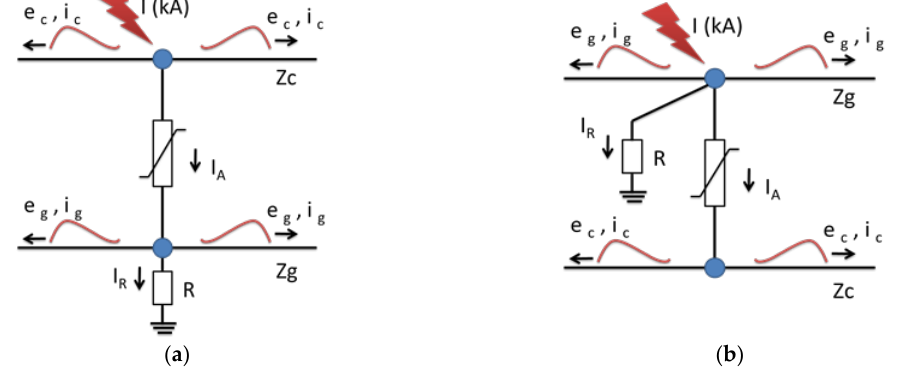
Figure 13. Result of a lightning strike to the phase conductor and overhead ground wire when the arrester is installed; ( a ) Strike to the phase conductor; ( b ) Strike to the overhead ground wire. The crest voltage at the phase conductor is given by